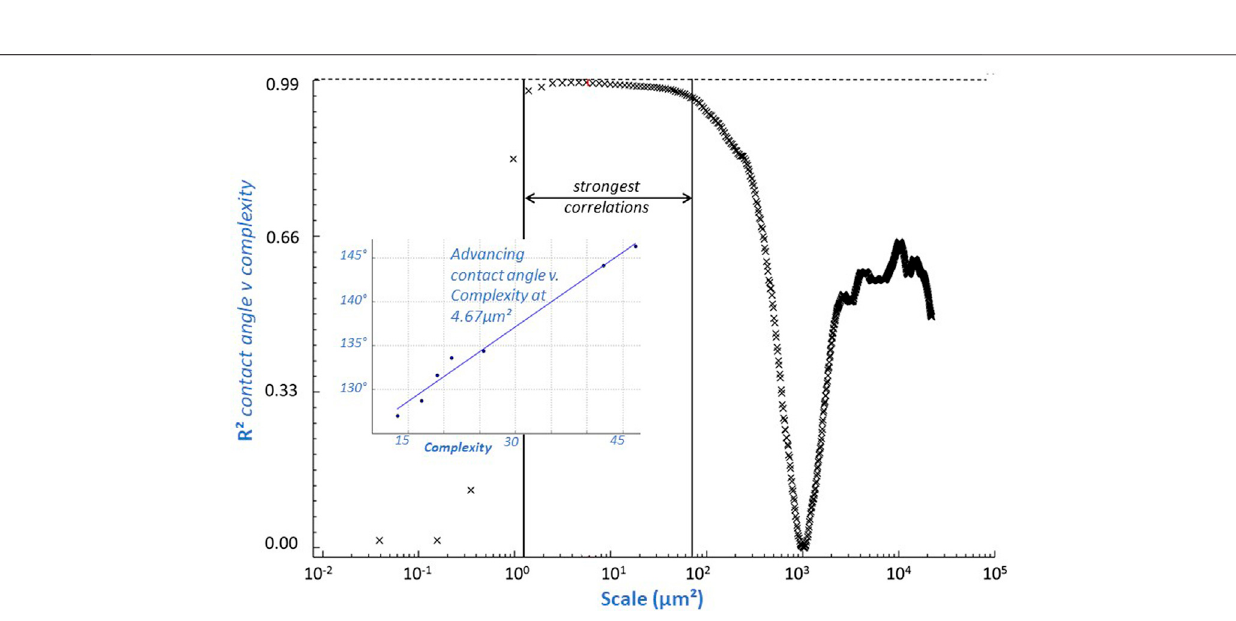
Frontiers in Mechanical Engineering |